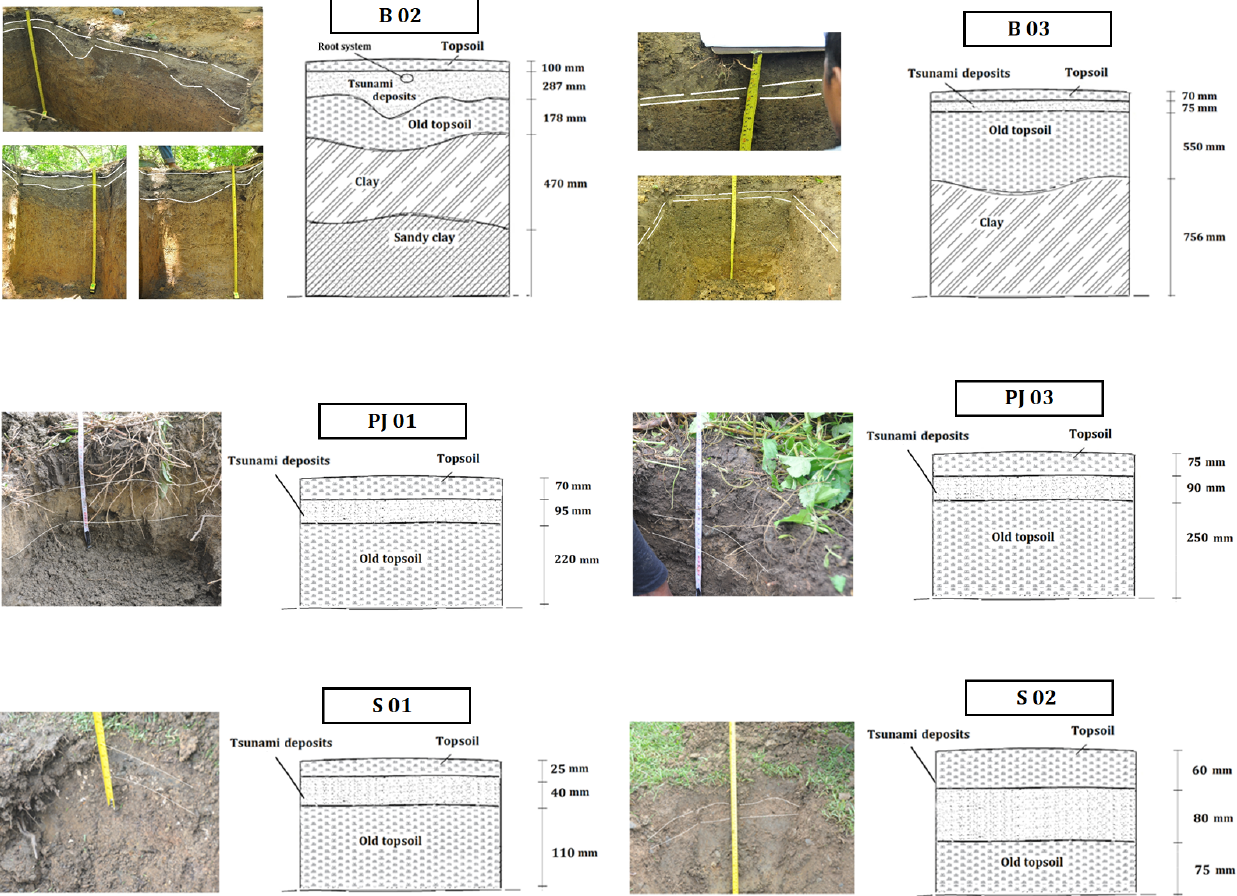
Figure 6. Profiles of tsunami deposit samples B02 and B03 at Birek, PJ01 and PJ03 at Pasie Janeng, and S01 and S02 at Saney.